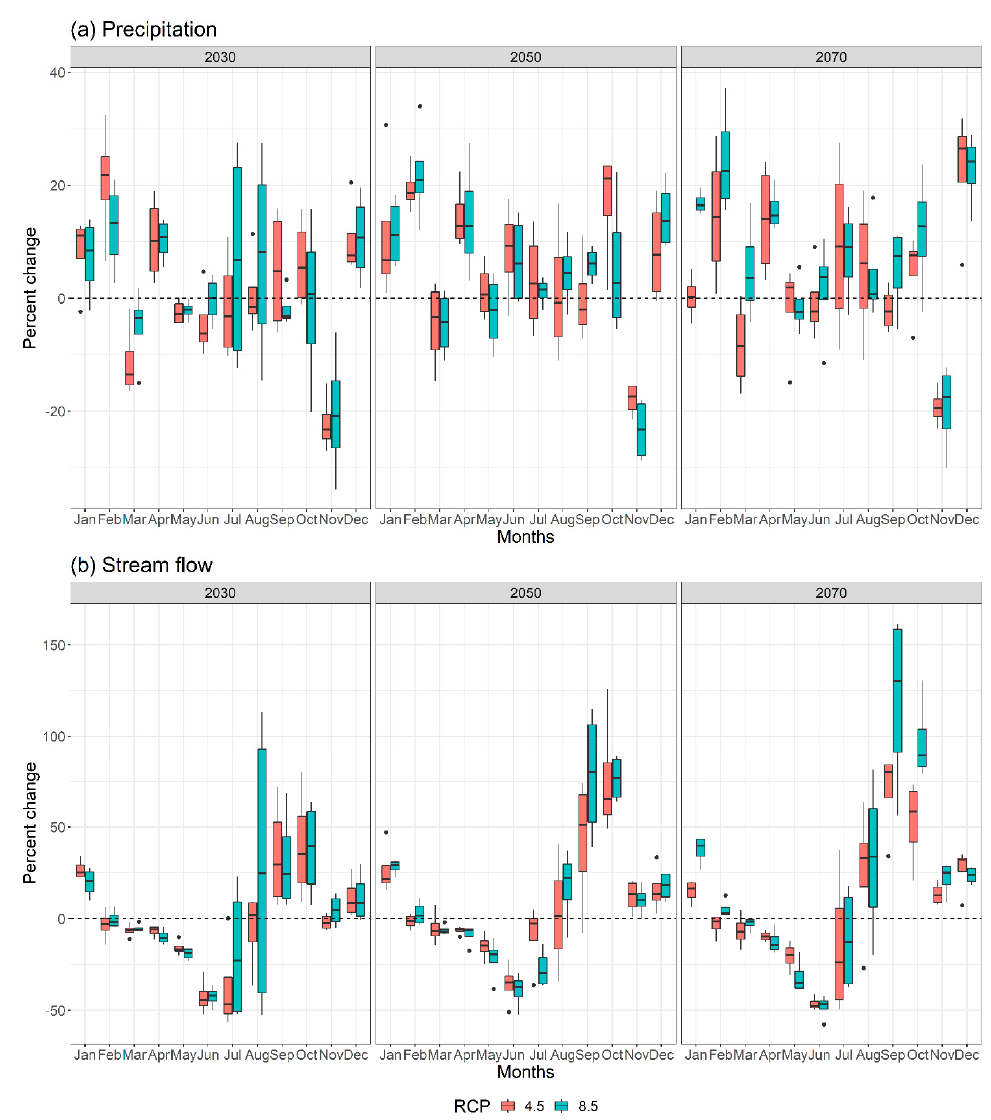
Figure 5. Projected monthly changes in water balance components ( a ) precipitation, ( b ) streamflow in Deckers Creek Watershed, Morgantown, West Virginia, USA. Box and whisker plot represent ensemble percentage change for four GCMs under two RCPs (RCP 4.5 and RCP 8.5). Projections are for 3 future periods of 20-year interval (2030= 2031 − 2050, 2050 = 2051 − 2070, 2070 = 2071 − 2090). The dotted line represents the historical baseline of 1980 −